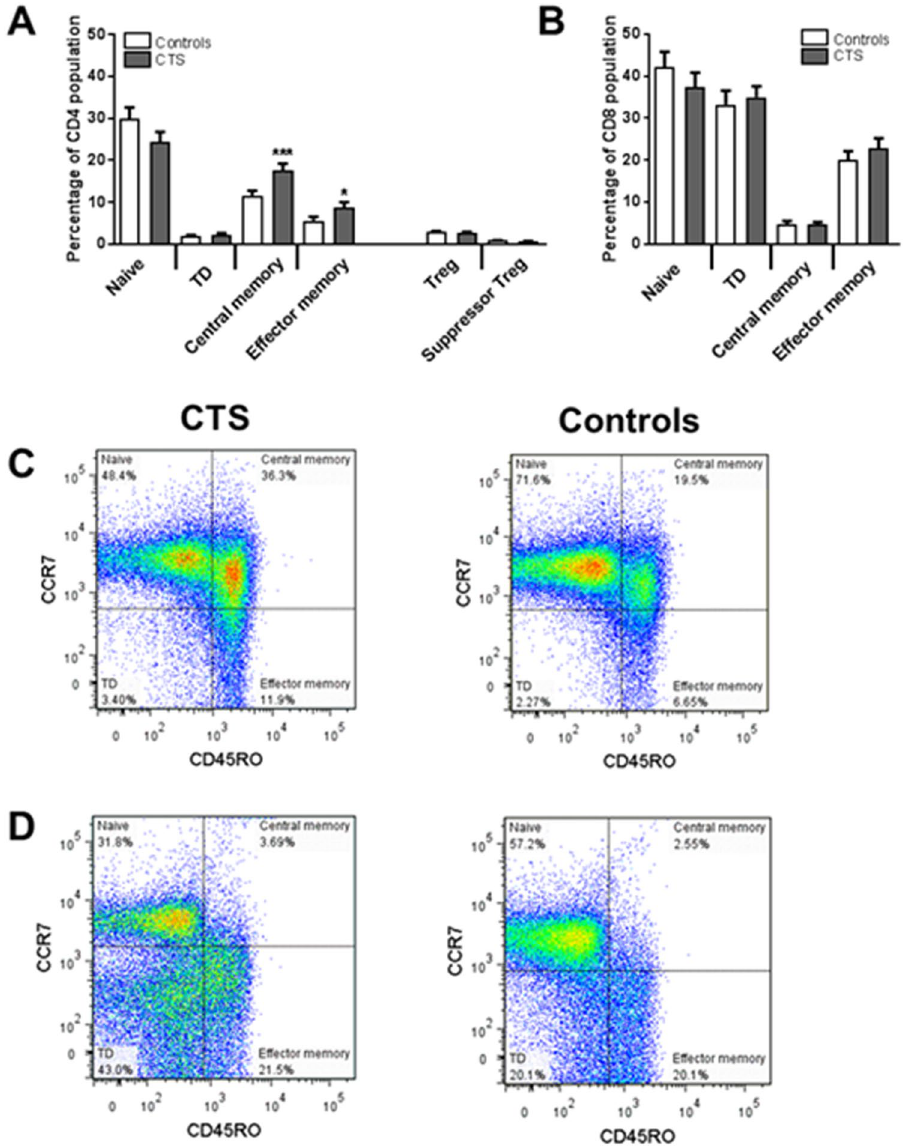
Figure 3. Increased CD4 + memory T cells in patients with CTS. Naïve and memory T cell subsets in PBMCs of patients with CTS (n = 26) and normal controls (n = 26) were identified by the expressions of CD45RO and CCR7 after gating on CD4 + or CD8 + T cells in PBMCs. CD4 + Treg cells were identified by the expression of CD25 high, CD127 low and Foxp3 + . Supressor Treg cells were further identified by double positive staining of CD39 and CD15s. ( A ) Percentages of naïve, terminally differentiated (TD), central memory and effector memory in CD4 + T cells, and CD4 + Treg cells and supressor Treg cells. ( B ) Percentages of naïve, TD, central memory and effector memory in CD8 + T cells. Columns represent mean + SEM. * P < 0.05; *** P < 0.005. Representative flow cytometry scatter plots are shown for ( C ) CD4 and ( D ) CD8 memory T cell populations for CTS patients (left panel) and control subjects (right